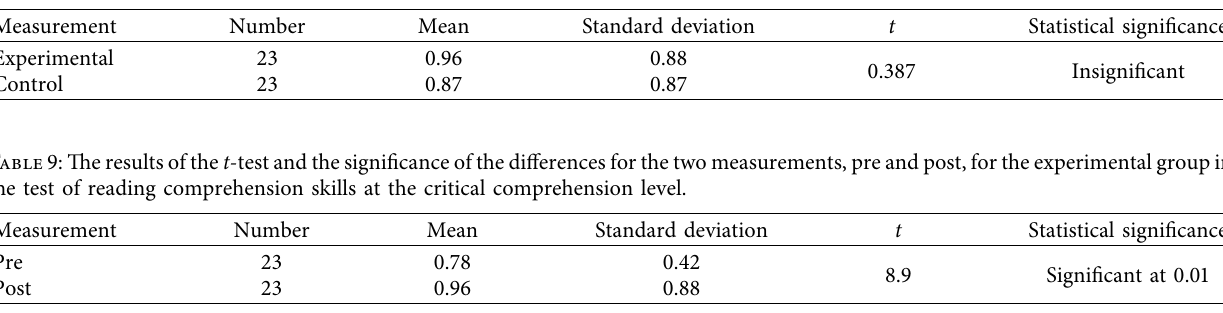
Table 8: The results of the t -test and the significance of the differences for the postmeasurement of the two groups, experimental and control, in testing the reading comprehension skills at the critical comprehension level.